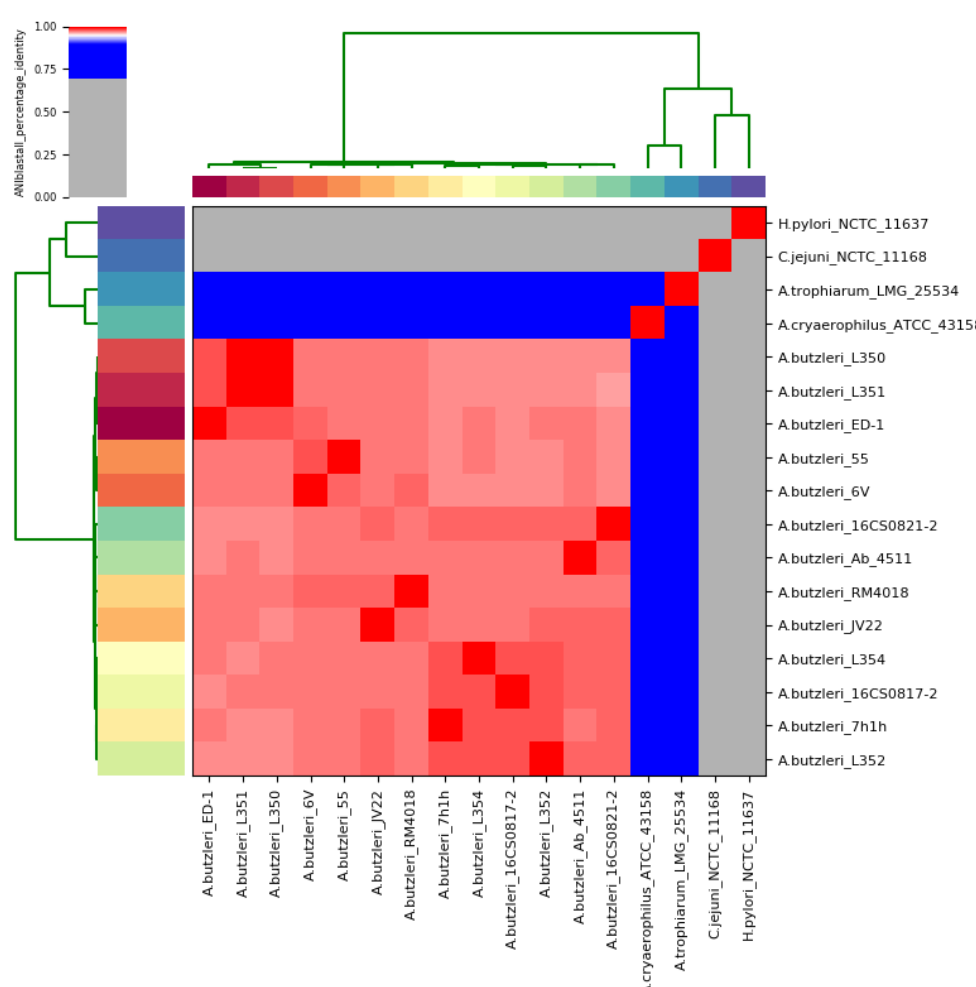
Figure 1. Results of the average nucleotide identity (ANI) analysis. The cells in the heatmap corresponding to an ANI value of 95% and higher are stained red. This indicates that the corresponding strains belong to the same species. Blue colored cells indicate that the corresponding strains do not belong to the same species. The dendrograms (in green; above and on the left side), which were constructed by the simple linkage of the ANIm percentage identities, correspond to the results of the clustering of the ANI values between the used strains [42] .